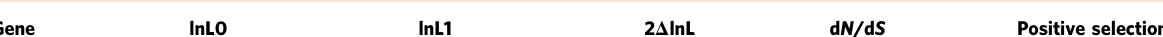
Table 1 Positive selection on mammalian TARDBP and SRSF9